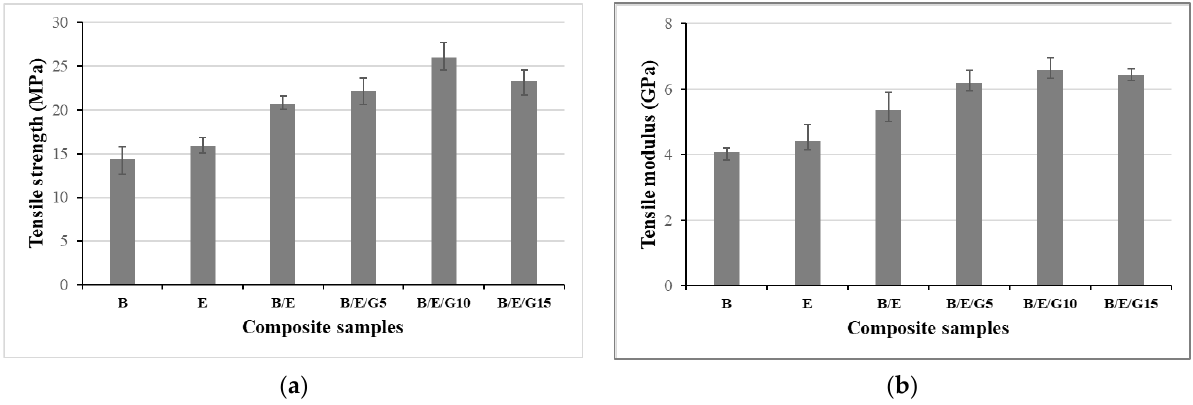
Figure 7. Tensile strength ( a ) and tensile modulus ( b ) of basalt and E-glass composite samples.